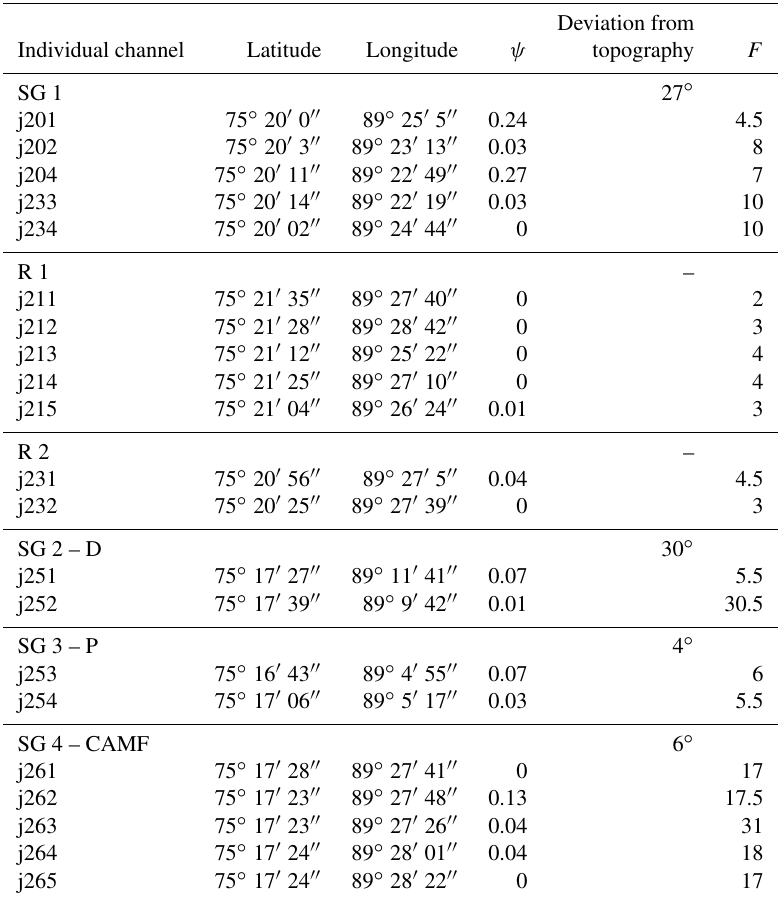
Table 2. Morphometric